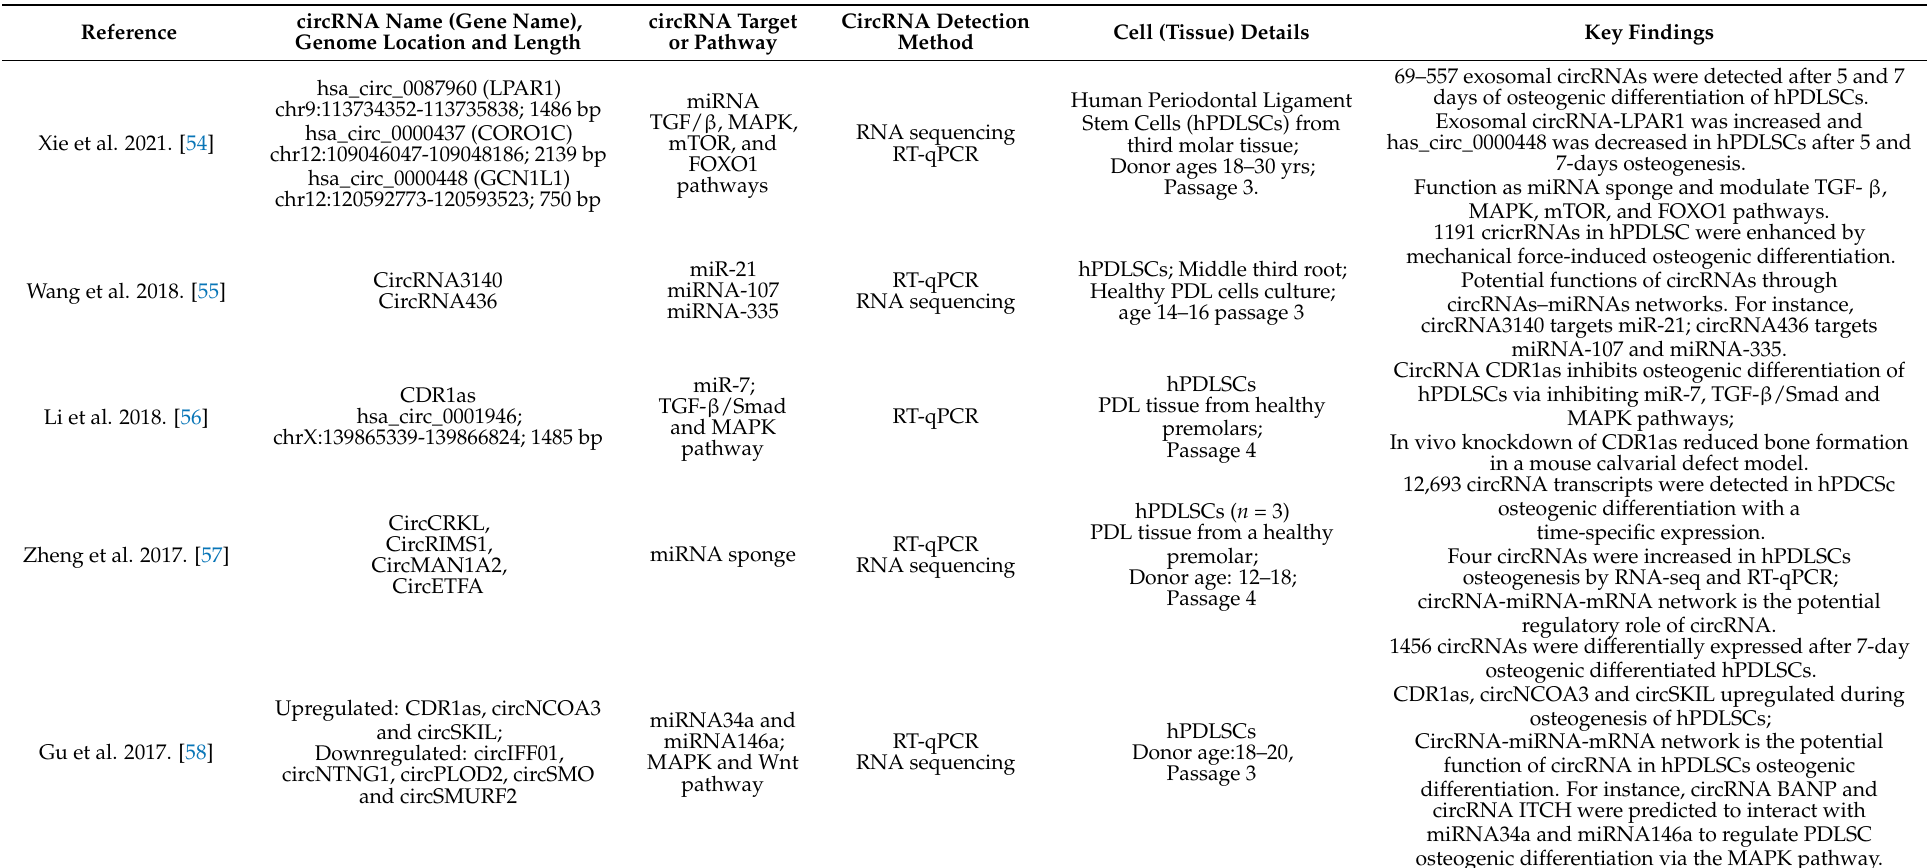
Table 2. Expression of circRNAs in human periodontal ligament stem cells